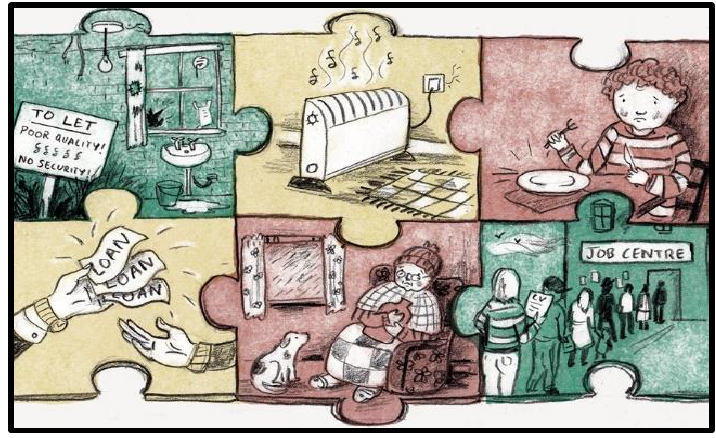
Figure 1. ‘The Jigsaw of Poverty’ by Life on the Breadline artist Beth Waters, 2018.